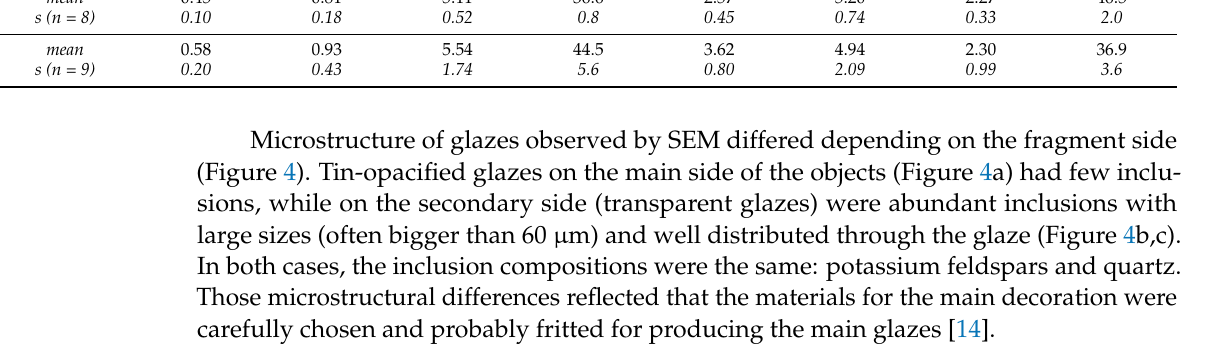
Table 3. Chemical composition (%wt) of glazes coating the secondary side of white glazed objects by EDS. Honey Glazes